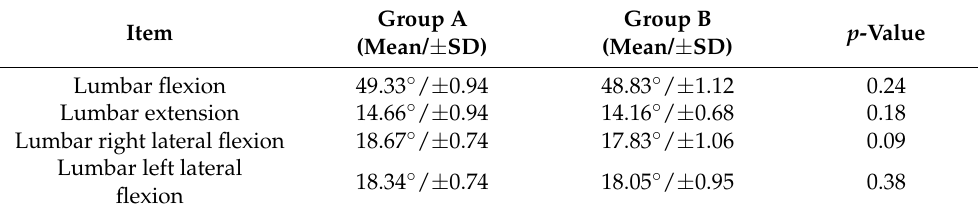
Table 2. Passive range of motion measurements in Group A and Group